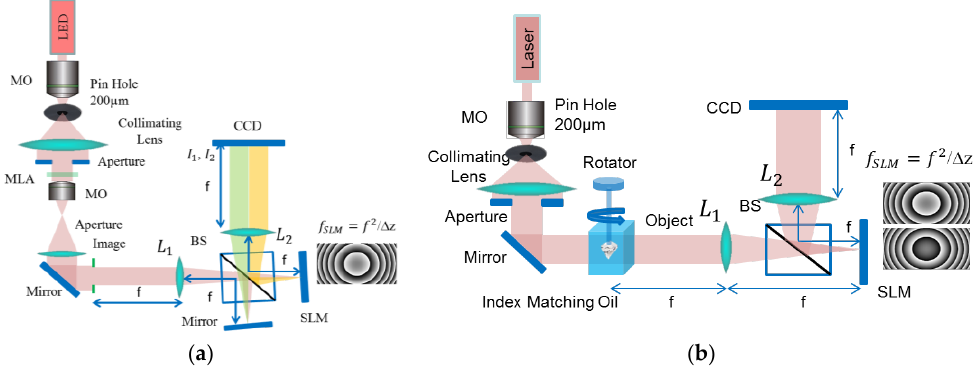
Figure 2. TIE optical setup: ( a ) Single-shot microscopy using a mirror and ( b ) sequential recording with rotating stage for full-view tomography of large phase objects. BO (beam splitter), MO (microscope objective), MLA (microlens array).